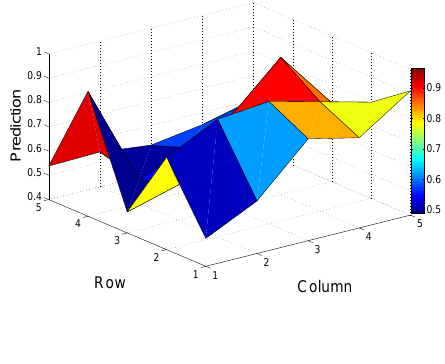
Fig. 18. The original traversability prediction of the experi- ment 3.